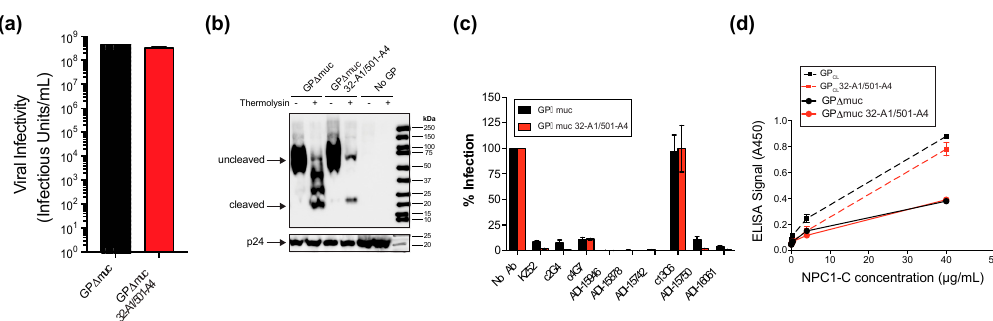
Figure 2. Characterization of pseudovirions containing peptide tags for site-specific fluorophore attachment. ( a ) Infectivity of pseudovirions containing either GP ∆ muc or GP ∆ muc 32-A1 / 501-A4 using a recombinant vesicular stomatitis virus (VSV) core that encodes GFP. Viral infectivity was determined by counting eGFP-positive Vero cells 14–16 h post infection. Results are shown as the mean ± standard error (n = 3). ( b ) Western blot of retroviral pseudovirions containing GP ∆ muc, GP ∆ muc 32-A1 / 501-A4 or no GP after 1 h mock treatment ( − ) or treatment with thermolysin (+) to cleave the glycan cap and generate GP CL . The HIV structural protein p24 indicates the total amount of virus loaded. ( c ) Neutralization of retroviral pseudoparticles by monoclonal antibodies. Antibodies were tested at 15 µg/mL for neutralizing activity against retroviral pseudoparticles containing either GP ∆ muc (black bars) or GP ∆ muc 32-A1 / 501-A4 (red bars). Luciferase activity was detected 48 h post-infection and expressed as a percentage of infection with no antibody (No Ab). Results are shown as the mean ± standard error (n = 2). ( d ) ELISA for NPC1-C binding to retroviral pseudovirions containing only GP ∆ muc or GP ∆ muc 32-A1 / 501-A4, with or without thermolysin treatment to generate GP CL or GP CL 32-A1/501-A4. Results are shown as the mean ± standard error (n = 3).